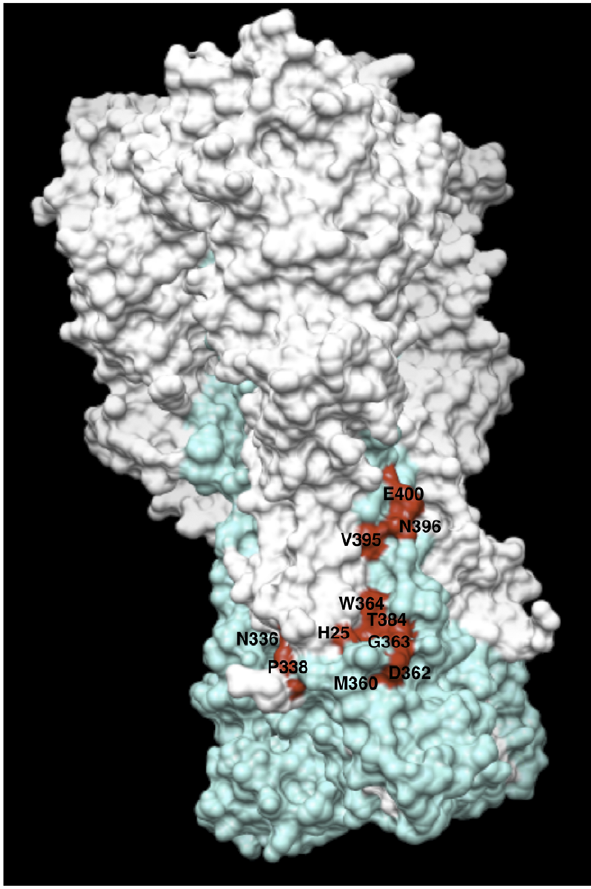
Figure 4. Amino acidic residues involved in the binding of PN- SIA49 to A/Puerto Rico/8/1934 (H1N1) hemagglutinin. The HA of A/Puerto Rico/8/1934 is represented as trimer with the HA1 domains colored white and the HA2 domains colored cyan. Mutations that affect the binding of PN-SIA49 are highlighted in red.